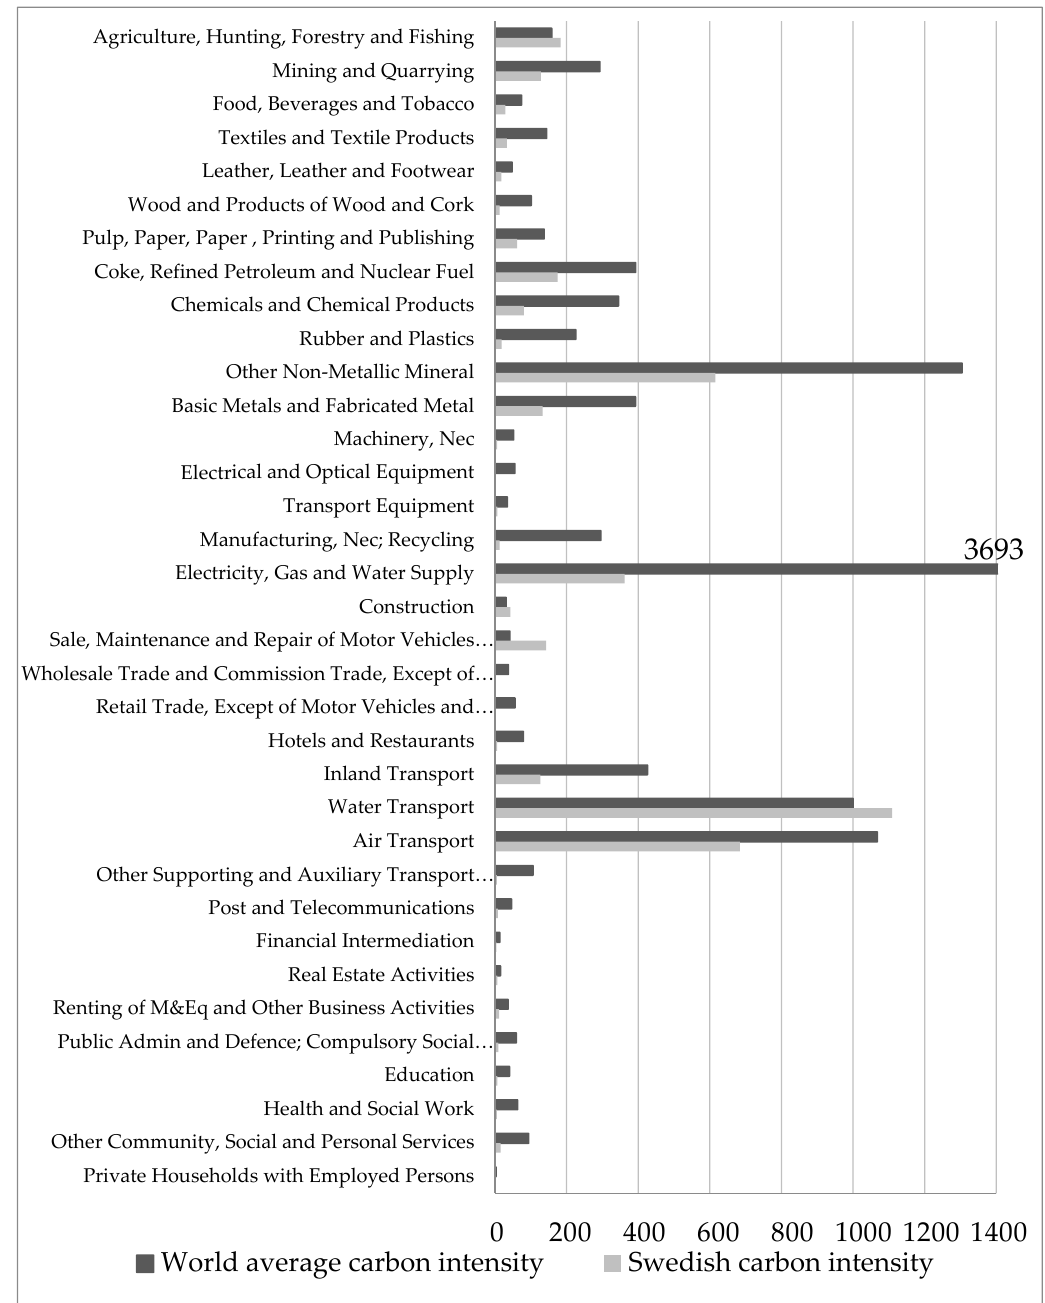
Figure 5. Swedish carbon intensity (CO2/$ of production, in green) v. world average (grey) in 2008.